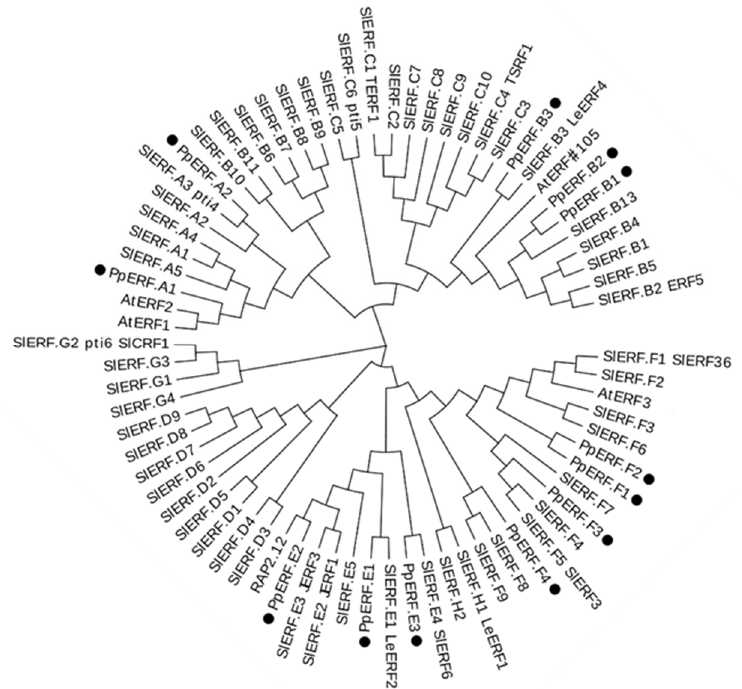
Figure 2. Phylogenetic tree derived from amino acid sequences of ERFs in peach, tomato, and Arabidopsis . The peach ERFs are highlighted with solid black circles. Full amino acid sequences of ERFs were aligned using Muscle software with default parameters, and a phylogenetic tree was constructed with MEGA software (version X) using the maximum likelihood method. All positions with less than 90% site coverage were eliminated, and ambiguous bases were allowed at any position (partial deletion option). The bootstrap consensus tree was inferred from 1000 replicates. All the tomato and Arabidopsis protein sequences were retrieved from Sol Genomics Network and Tair, respectively.